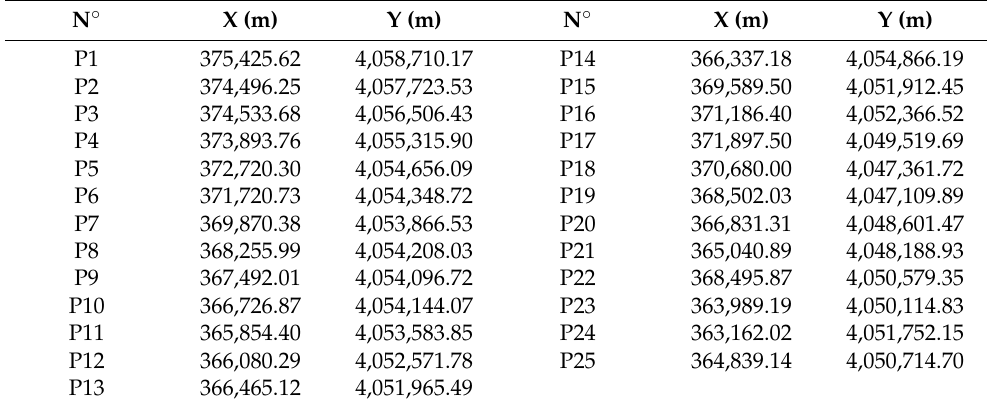
Table 1. UTM Coordinate system of measurement locations in Madjez Ressoul catchment.